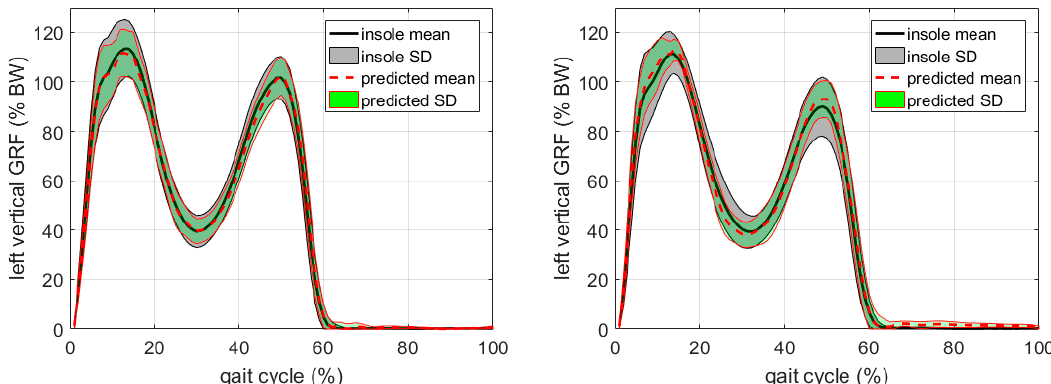
Figure 2. Proxy measured GRF (mean red thick broken line ± 1 SD red thin lines) compared with insole data (mean (black thick line) ± 1 SD (grey shaded area)); left figure: outdoor controlled walking (OCW), right figure: outdoor free walking (OFW).